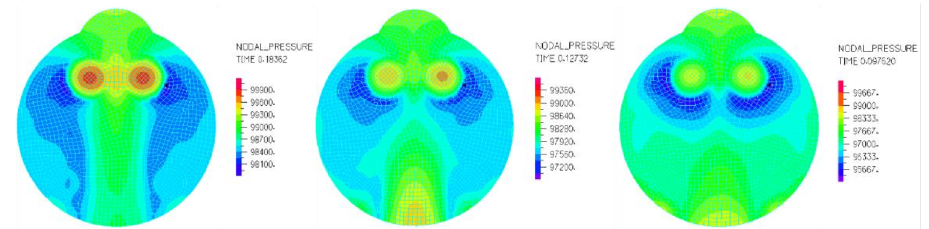
Figure 15. Pressure distribution on the upper surface of the reed (1050, 1500, and 1950 r · min − 1 ).